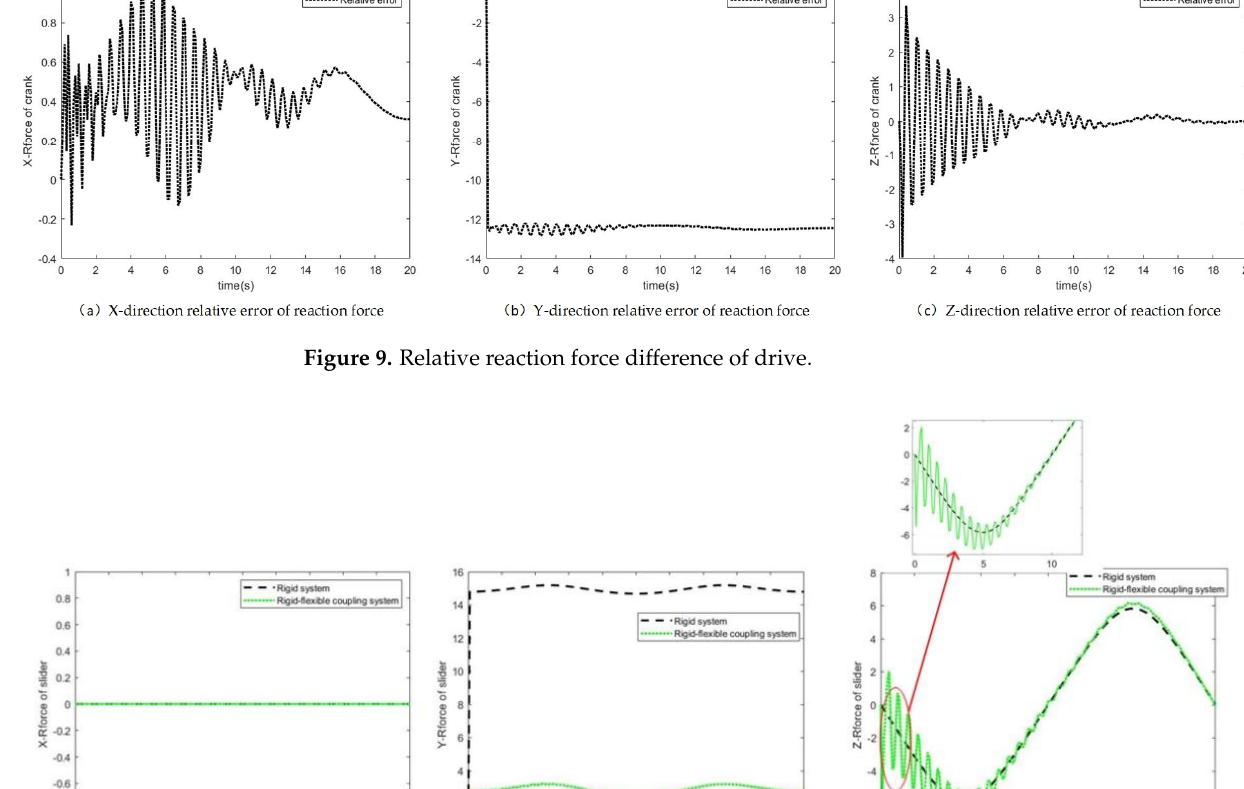
Figure 8. Reaction force of drive.